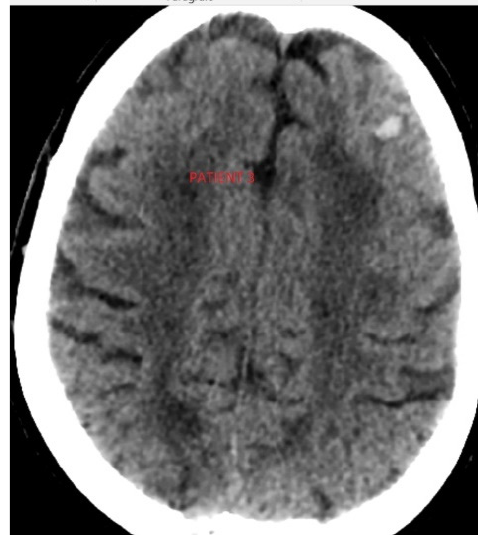
Figure 3. Basal CT scan after the ischemic event in patient